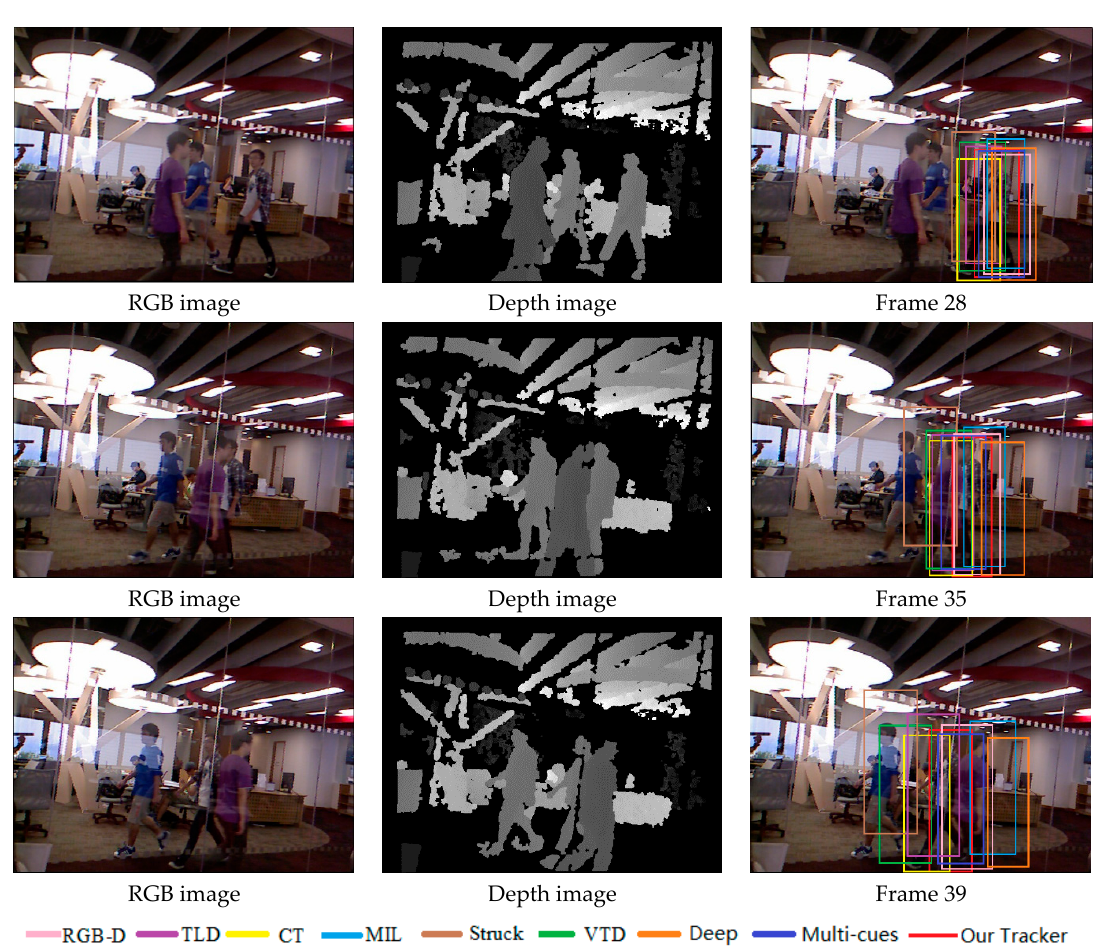
Figure 10. The tracking results on the test video 4 obtained by different methods.